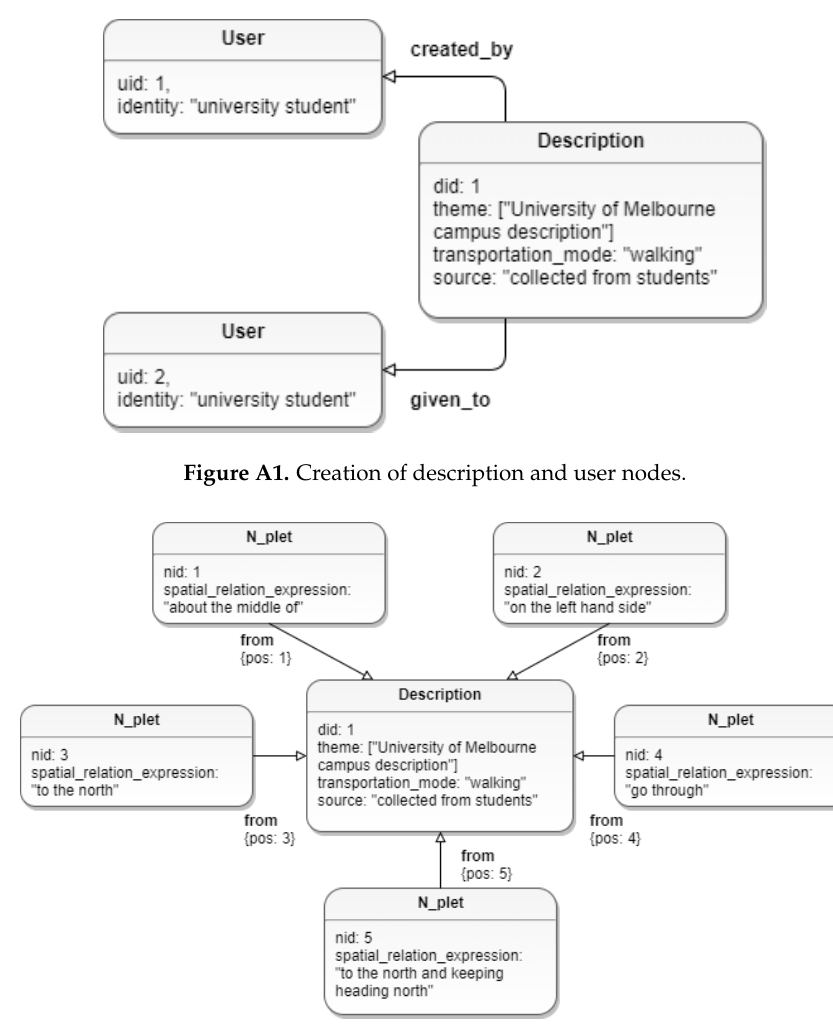
Figure A2. Creation of n -plet nodes.